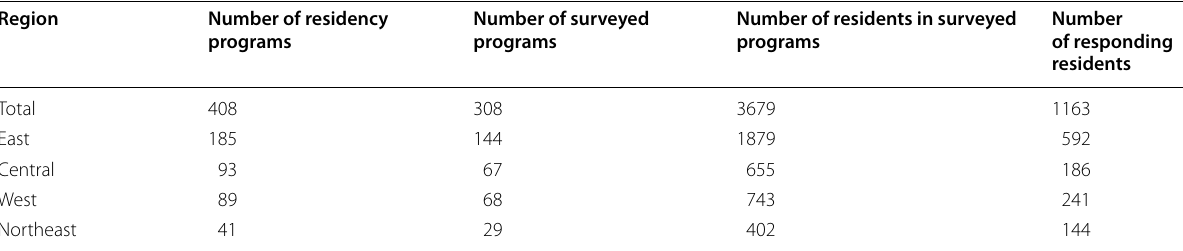
The four regions were defined by China’s National Bureau of Statistics based on the geographic location and economic status. The eastern region contains 10 highly developed coastal provinces and municipalities, including Beijing, Tianjin, Hebei, Shanghai, Jiangsu, Zhejiang, Fujian, Shandong, Guangdong and Hainan. The central region includes 6 provinces, including Shanxi, Anhui, Jiangxi, Henan, Hubei and Hunan. The western region includes 12 less developed provinces and municipalities, including Inner Mongolia, Guangxi, Chongqing, Sichuan, Guizhou, Yunnan, Tibet, Shaanxi, Gansu, Qinghai, Ningxia and Xinjiang. The northeastern region consists of 3 provinces, including Liaoning, Jilin and Heilongjiang